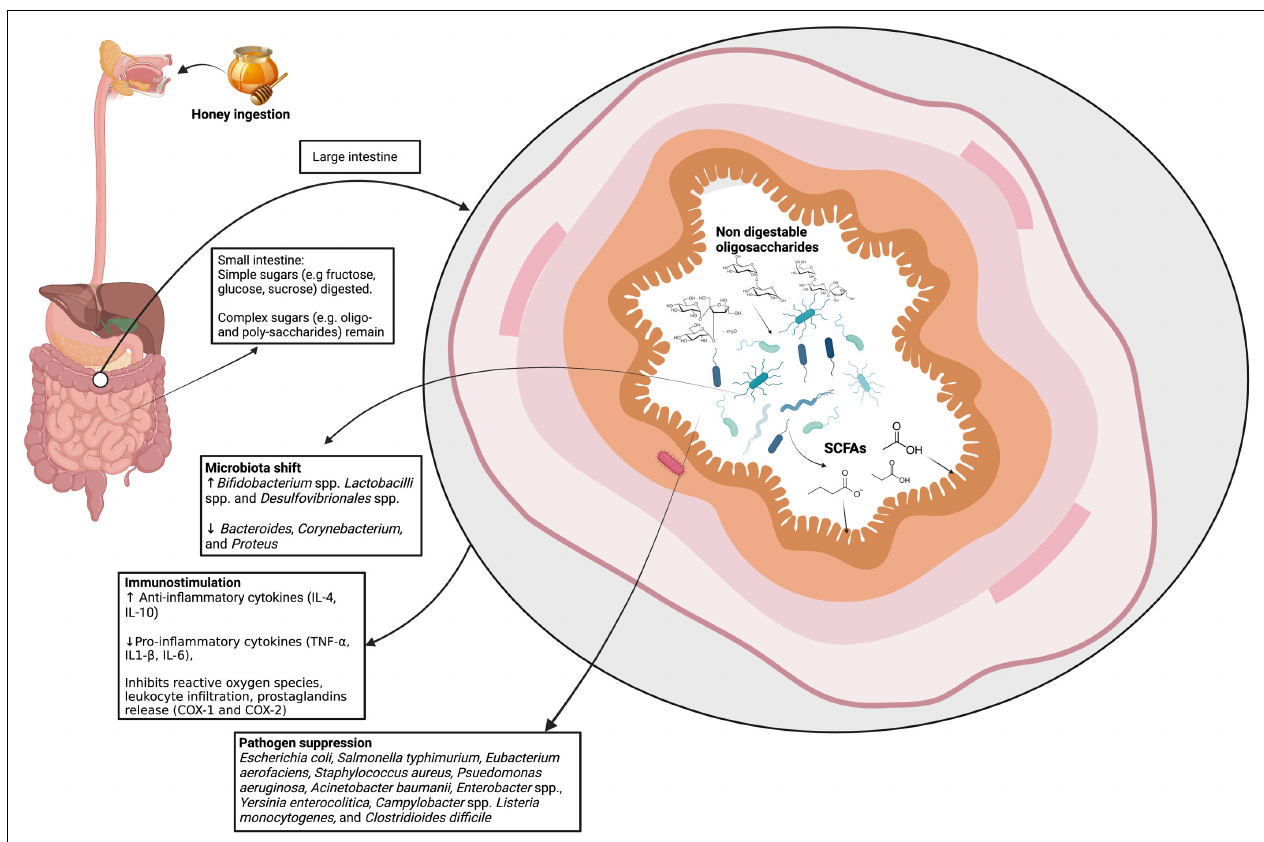
FIGURE 1 | The proposed prebiotic effects of honey. Following ingestion, the simple sugars in honey are absorbed in the small intestine. The non-digestible components, including oligosaccharides, reach the lower intestines where they are proposed to be involved in immunostimulation, modulating the microbiota, and suppressing pathogens. SCFAs, short-chain fatty acids; IL, interleukin; TNF, tumor necrosis factor; COX, cyclooxegenase. Image created with